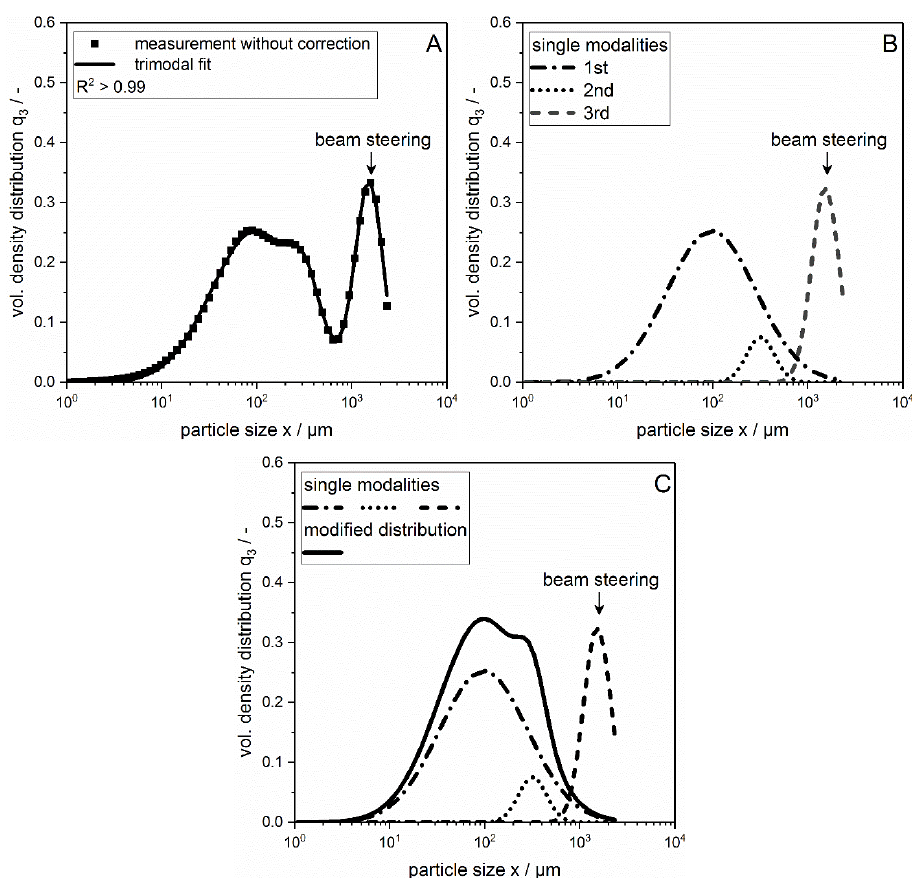
Figure 6. Procedure of beam-steering correction, exemplarily presented at a measurement with overlapping real and apparent droplet size distribution (µ = 0.69 Pa·s; p G = 0.8 MPa; 𝑉̇ 𝐿 = 20 L/h; GLR = 0.35): ( A ) Trimodal log-normal fit of the measured droplet size distribution. ( B ) Split in single modalities. ( C ) Formation of modified droplet size distribution.